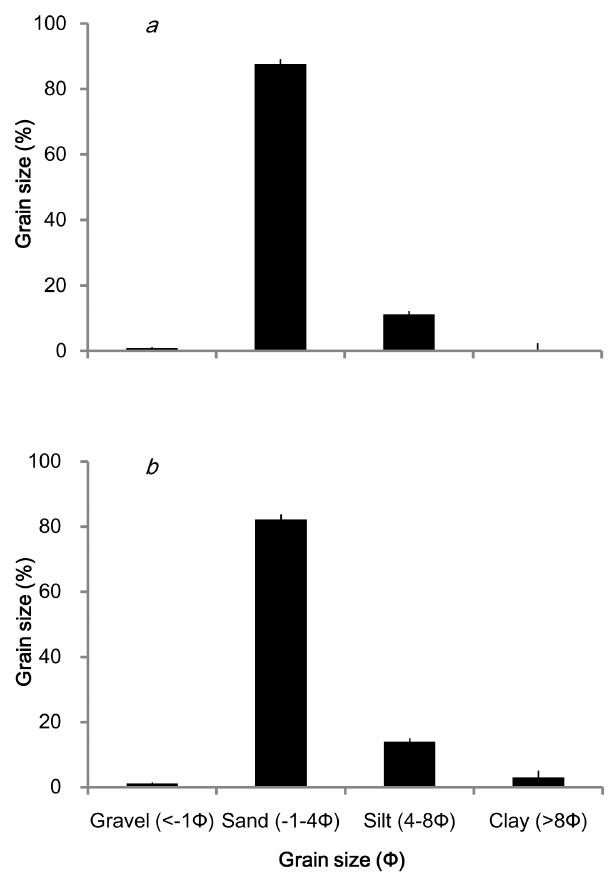
Figure 5. Particle size spectra of sediments in natural ( a ; Huiquan Bay) and transplanted Zostera marina areas ( b ; Qingdao Bay). Values are means 6 SD.